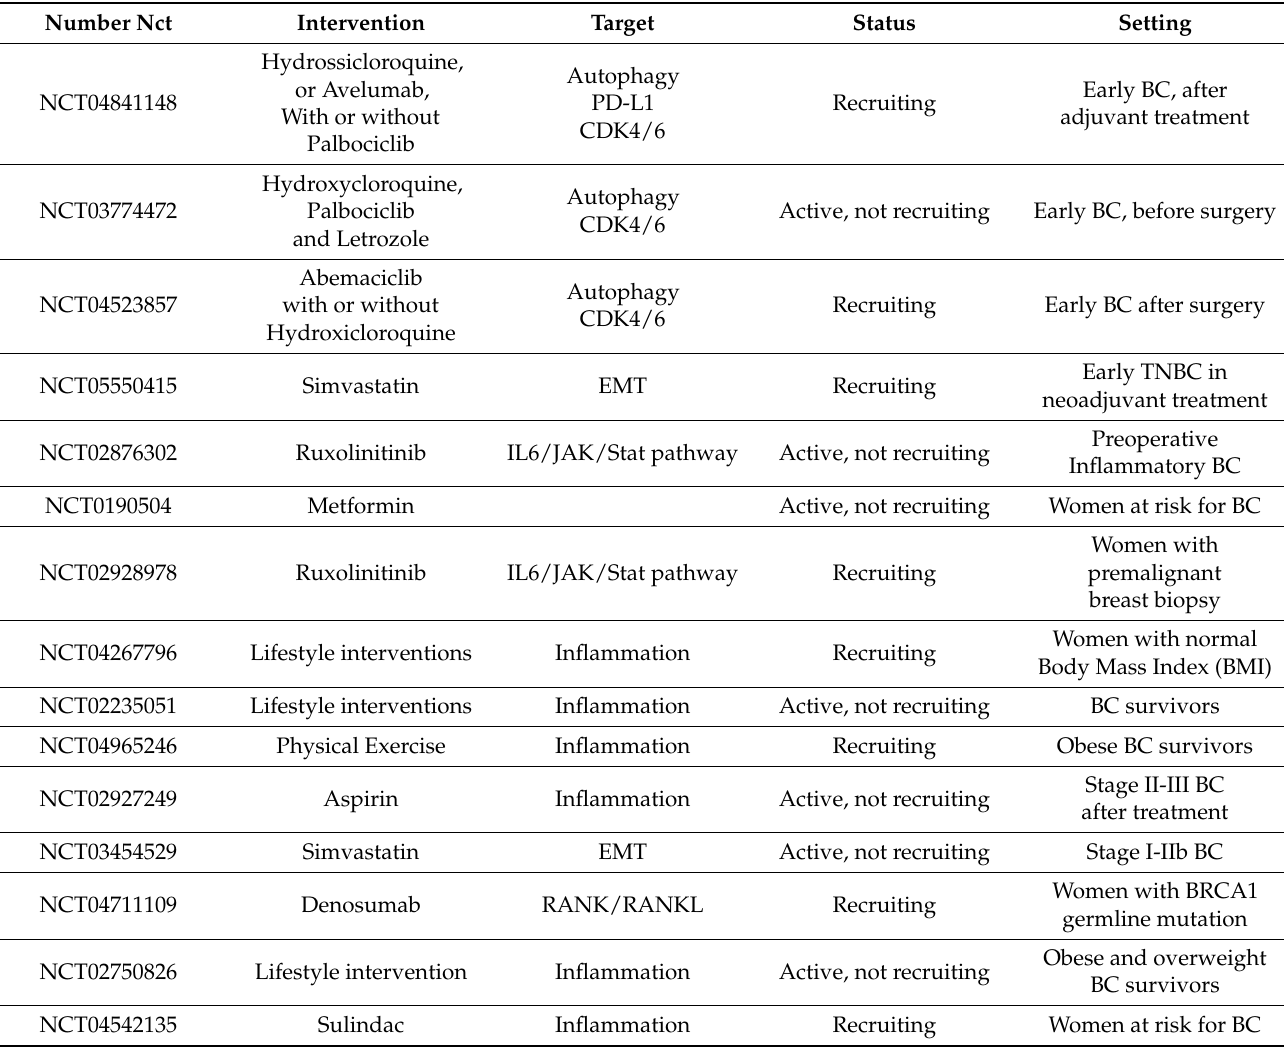
Table 1. List of ongoing trials with a dormancy-based